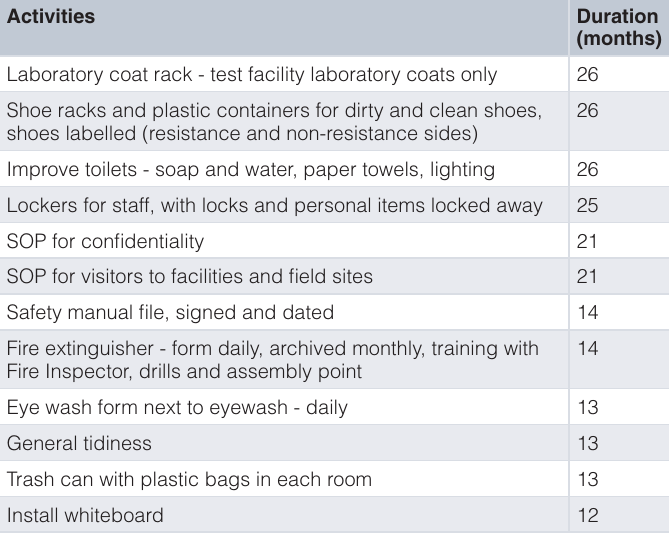
Table 2. Activities requiring more than 12 months to complete and were not included in WHO GLP Handbook